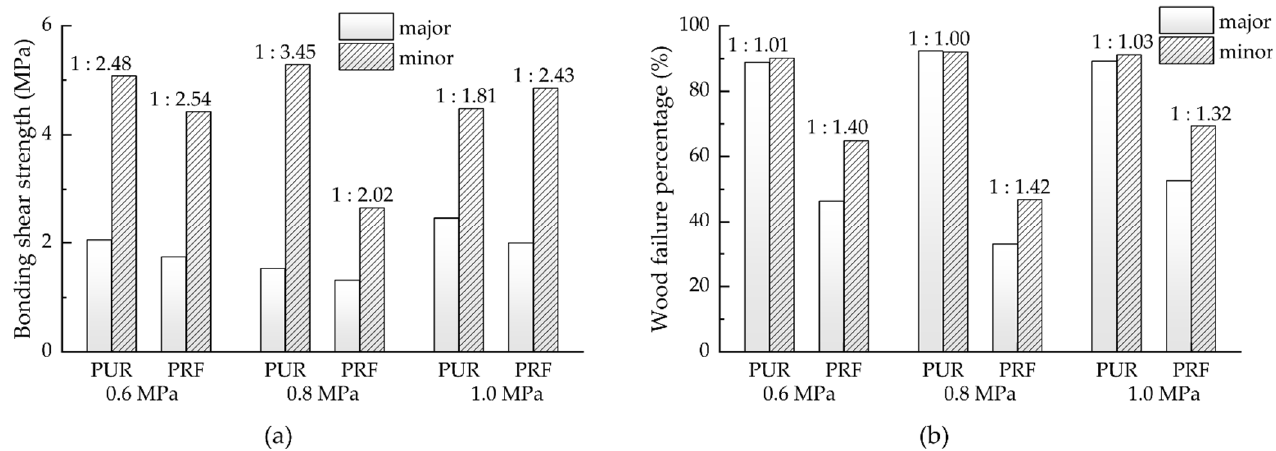
Figure 3. Bond shear properties of CLBT loaded in different directions: ( a ) bonding shear strength, ( b ) wood failure percentage.